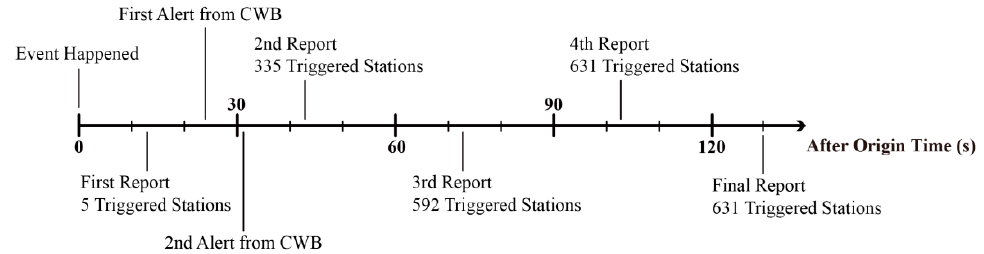
Figure 6. The difference in reporting by P -Alert and CWB network. The first report is generated by the P -Alert network with the triggering of 5 stations after 13 s of earthquake occurrence. CWB issued the first alert after 24 s and the second alert after 32 s. P -Alert generated the 2nd report after 43 s and the final shakemaps with triggering of 631 instruments were available approximately after 130 s.